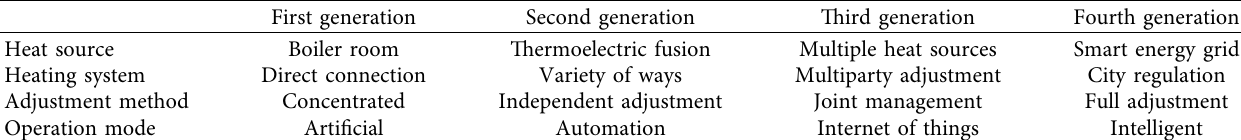
Table 1: Age division of heating technology.